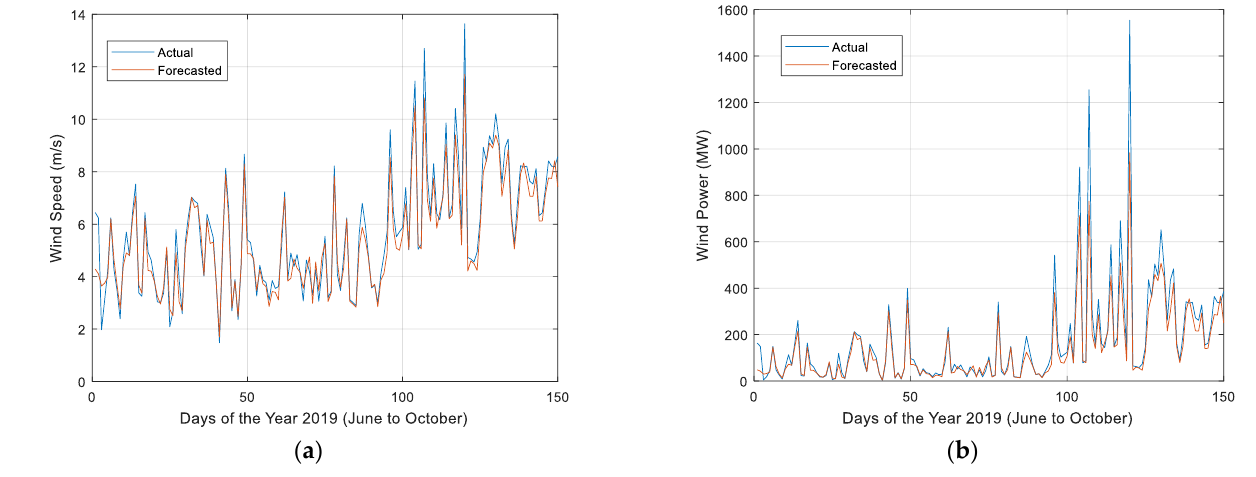
Figure 12. ( a ) Comparative analysis of wind speed forecasting by the FFNN trained through PSO. ( b ) Comparative analysis of wind power forecasting by the FFNN trained through PSO.